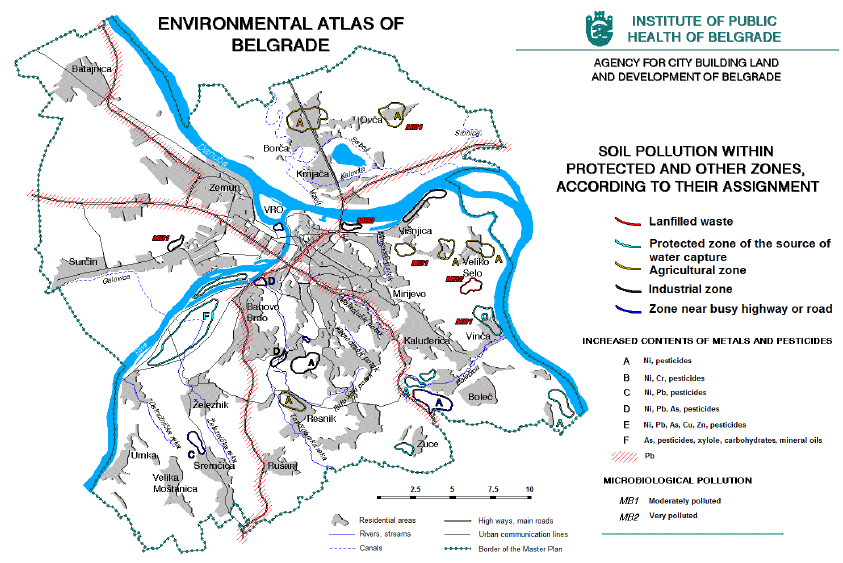
Figure 6. Quality of the surface water and monitoring network (https://www.zdravlje.org.rs/ekoat- las/volbe/39ev.gif, accessed on 23 August 2022). ekoatlas/volbe/39ev.gif, accessed on 23 August 2022).